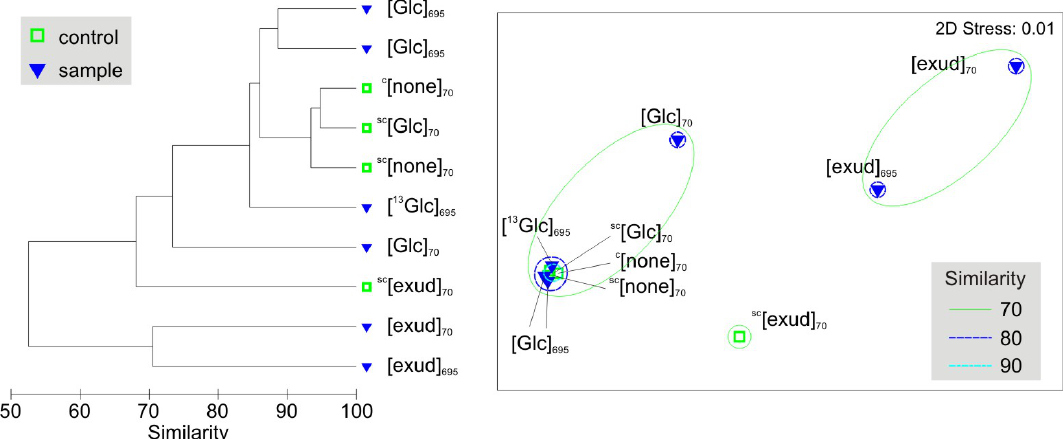
Figure 7. Sample comparison based on hierarchical cluster analysis (left panel) and multidimensional scaling (right panel). Relative peak magnitudes of all identified molecular formulas (isotopologues excluded) were compared based on Bray–Curtis similarity and group average